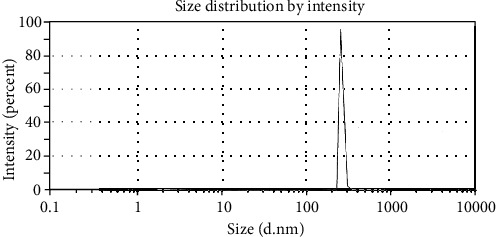
Particle size distribution curve by the intensity of CXB in PEG 600 80% v/v.